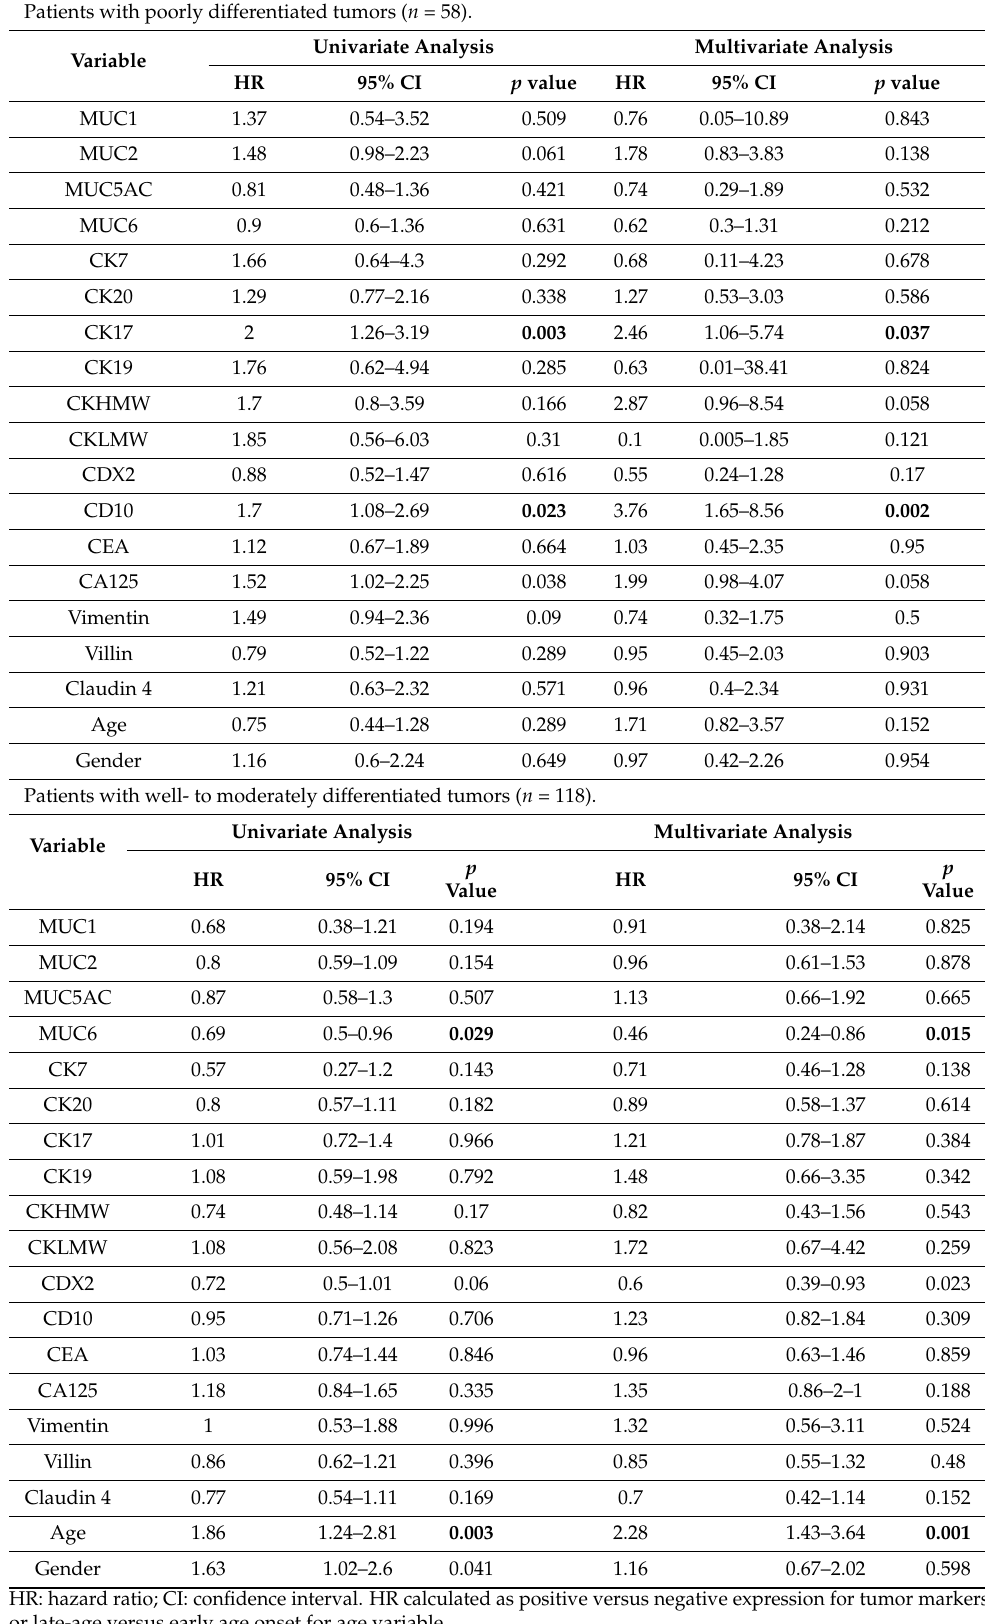
Table 3. Univariate and multivariate Cox survival analysis of GBC patients. Patients with poorly differentiated tumors ( n =